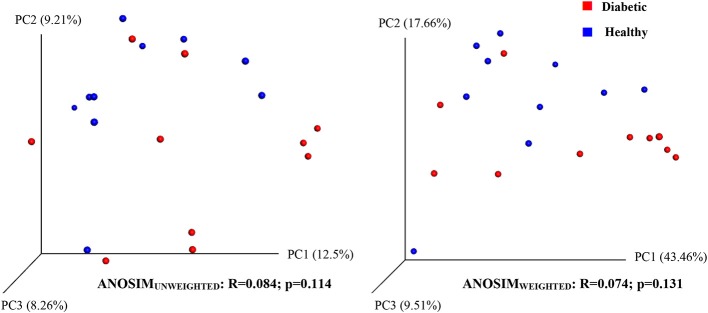
Principal coordinate analysis (PCoA) plot showing clustering of microbial communities from feces of healthy and diabetic dogs (red = diabetic, blue = healthy). The microbiome (beta diversity) of healthy dogs did not differ from that of diabetic dogs (ANOSIM; p = 0.114).